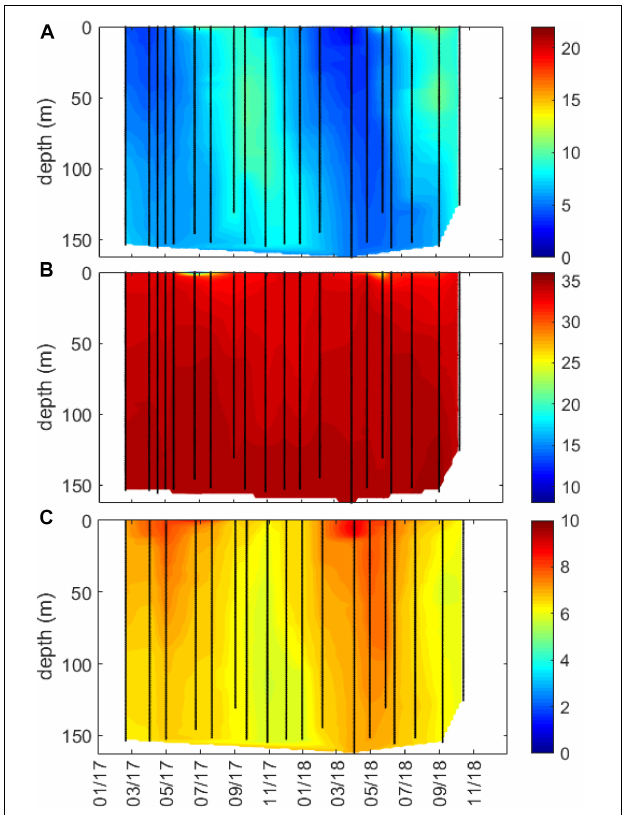
FIGURE 8 | Full water column profiles (from 0 m to near bottom) for coastal station Straumsfjorden in study region Malangen/northern Norway for (A) temperature ( ◦ C), (B) salinity, and (C) oxygen (mL L − 1 ). Data are interpolated, with black symbols showing location of sampling.